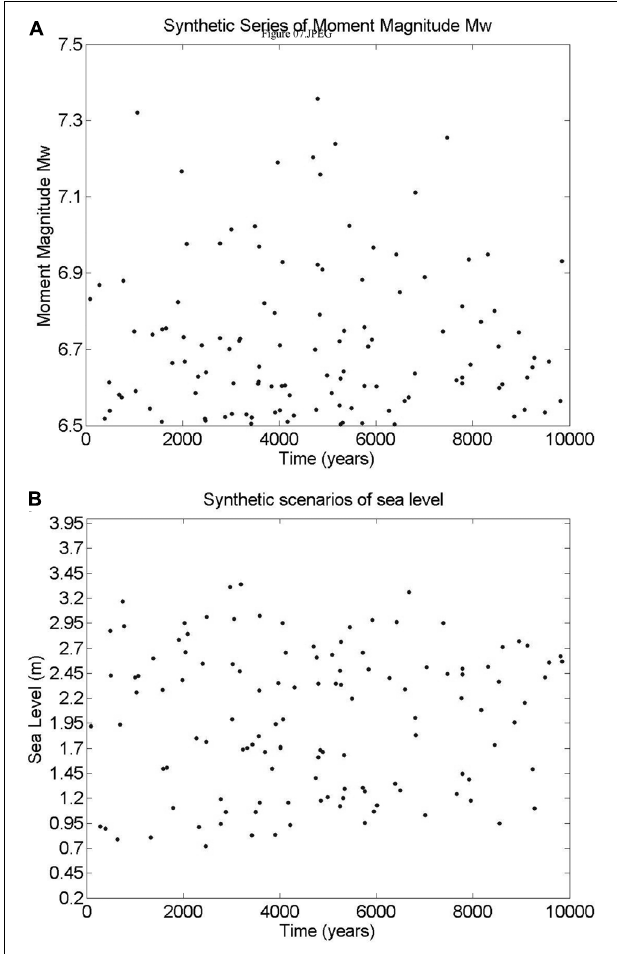
FIGURE 7 | Example of one time series of Moment magnitude (10000 years) for seismic events greater than 6.5 in all source regions (A) and associated sea levels (B)